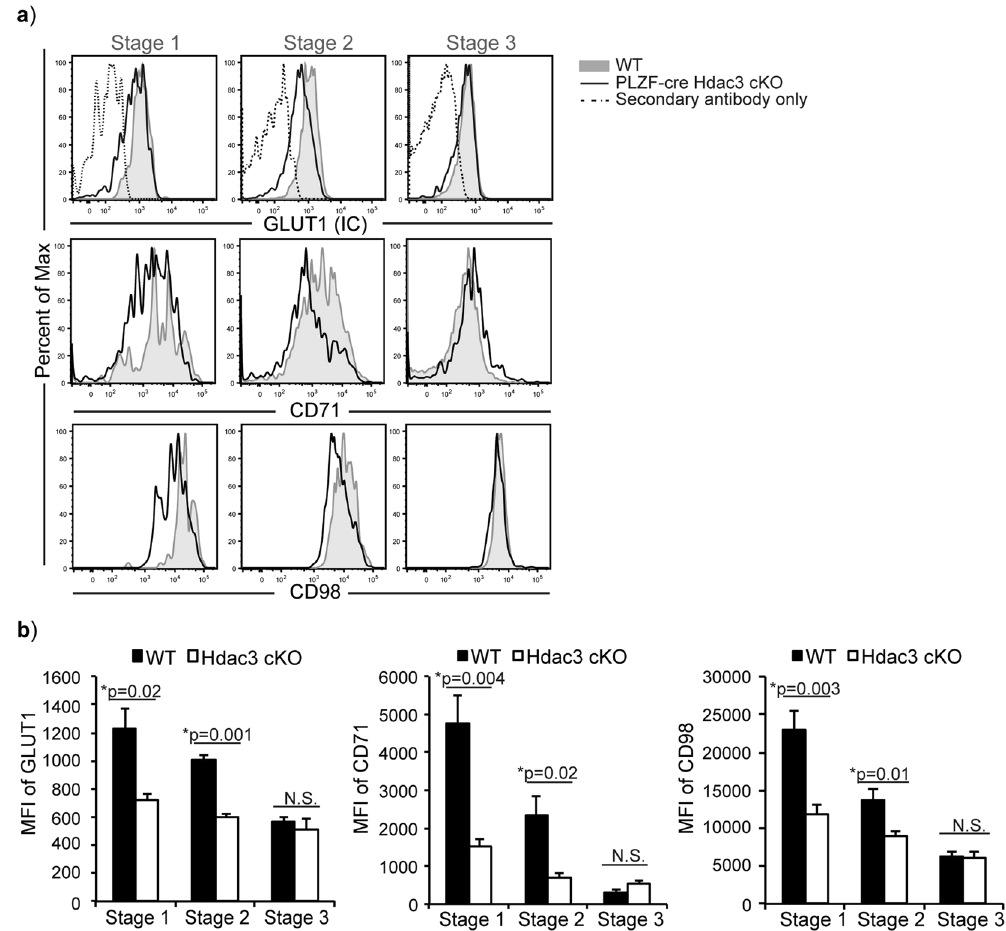
Figure 6. Loss of Hdac3 affects expression of nutrient receptors CD71, CD98 and GLUT1. ( a ) Expression of GLUT1 (intracellular), CD71 (surface), and CD98 (surface) in Stage 1–3 iNKT cells of WT (grey filled) and PLZF-cre Hdac3 cKO (black line). Secondary antibody (fluorescent labeled) only control (dashed) is shown for GLUT1 where unlabeled primary antibody against GLUT1 was used. CD71 and CD98 antibodies were directly conjugated to fluorophores. Data is representative of at least 4 mice/genotype from 3 independent experiments. Staining and gating for each iNKT cells stages was performed as described in Fig. 1. ( b ) Quantification of average MFI of GLUT1, CD71 and CD98 expression in Stage 1–3 iNKT cells of WT (black bars) and PLZF- cre Hdac3 cKO (white bars) mice. Data is calculated from 4 mice/genotype from 3 independent experiments. Statistical analysis was done using student’s t test. Means ±